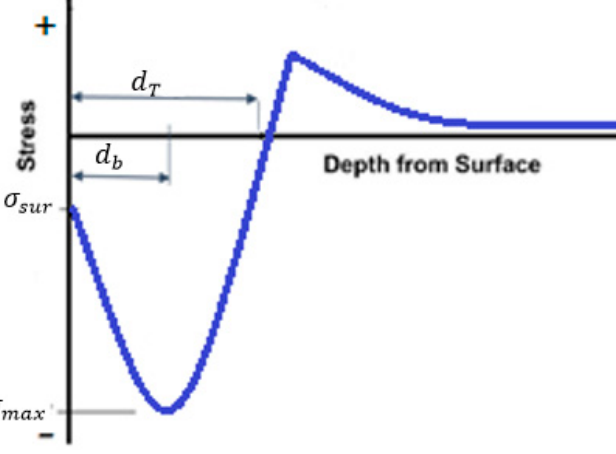
Figure 1. A typical residual stress profile due to shot peening.